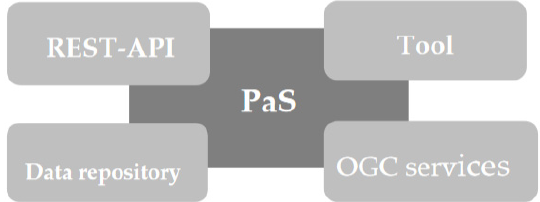
Figure 1. Components of the PaS platform.